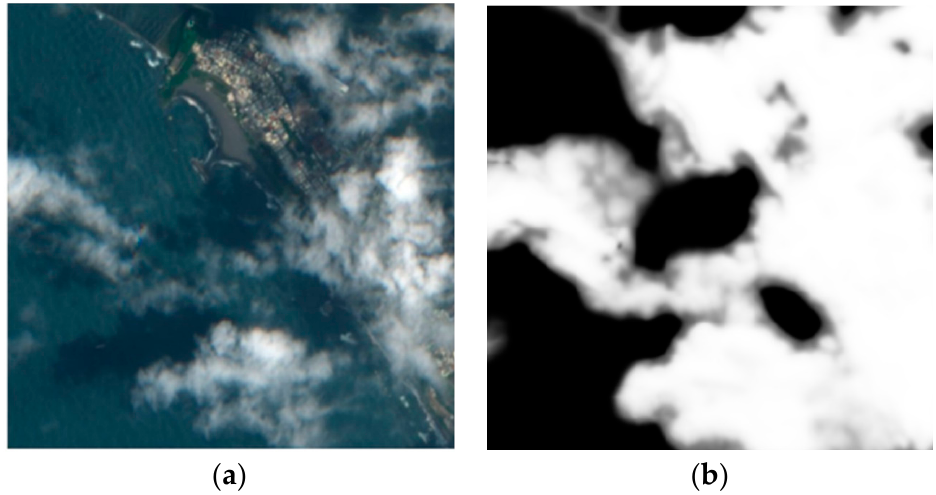
Figure 15. Sea–land segmentation results are interfered with by large areas of cloud and fog. ( a ) Satellite image ( b ) Classification result.